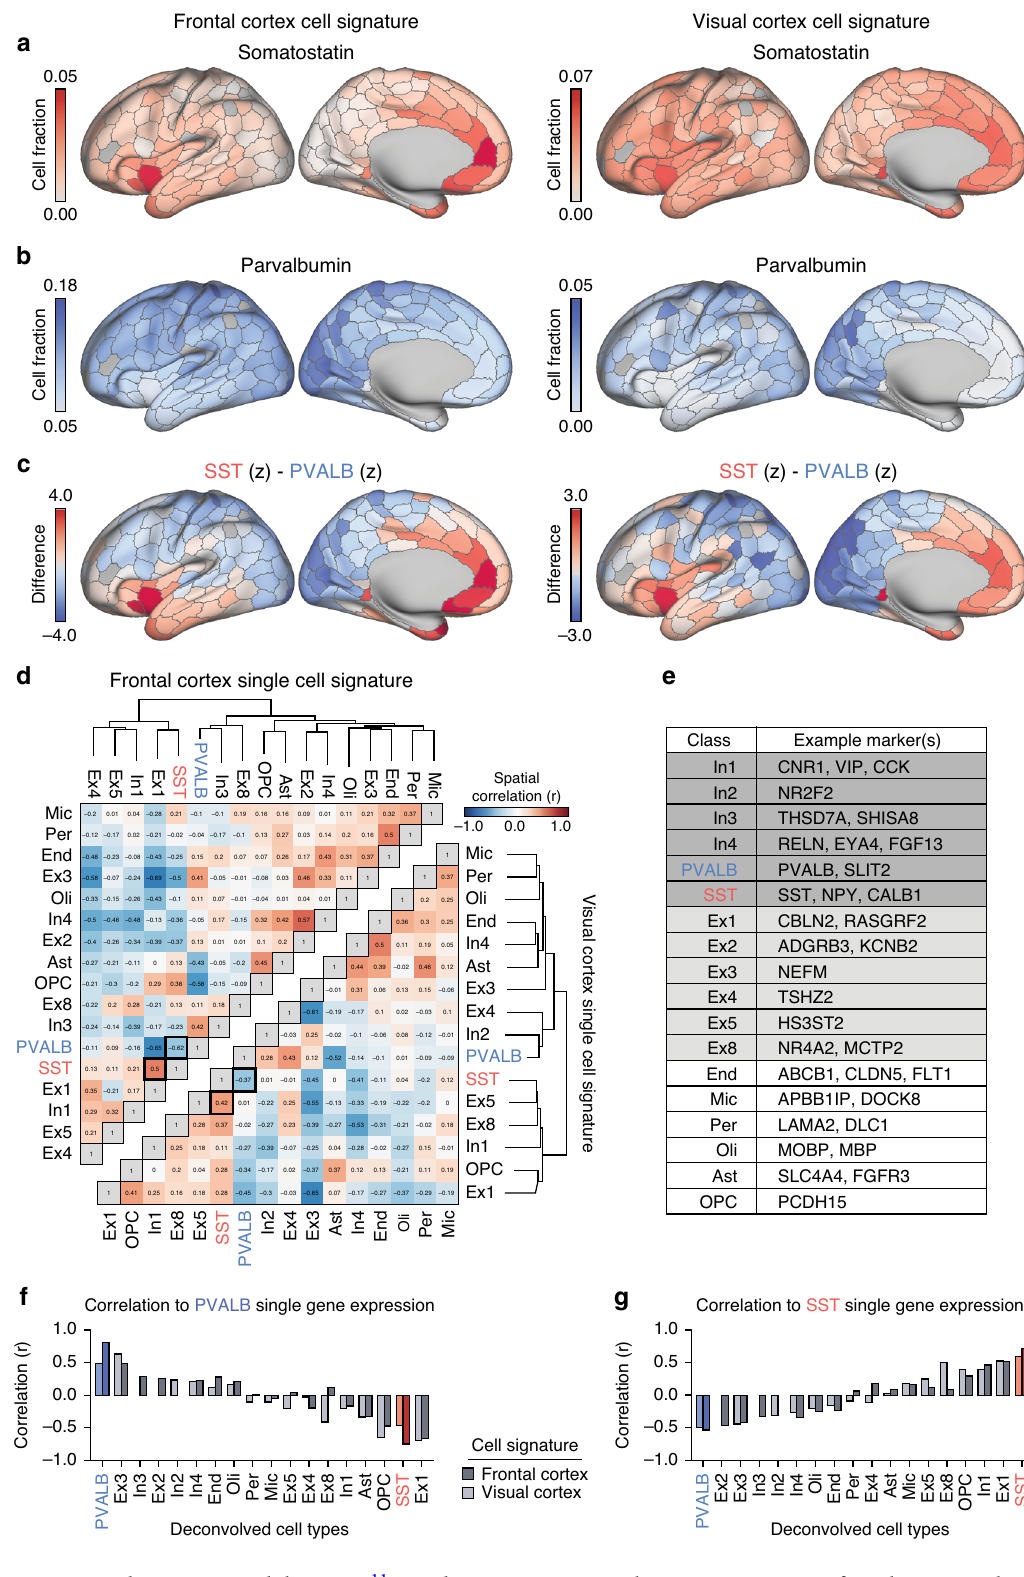
correspondence to non-human animal literature 11 . Median z - transformed SST and PVALB was calculated for subdivisions of each subcortical region (Supplementary Fig. 9). Across 40 AHBA subcortical sub-regions, 31 were able to be mapped onto rodent homologs present in cell density (cells per mm 3 ) data from Kim and colleagues 11 . The relative presence of human SST and PVALB